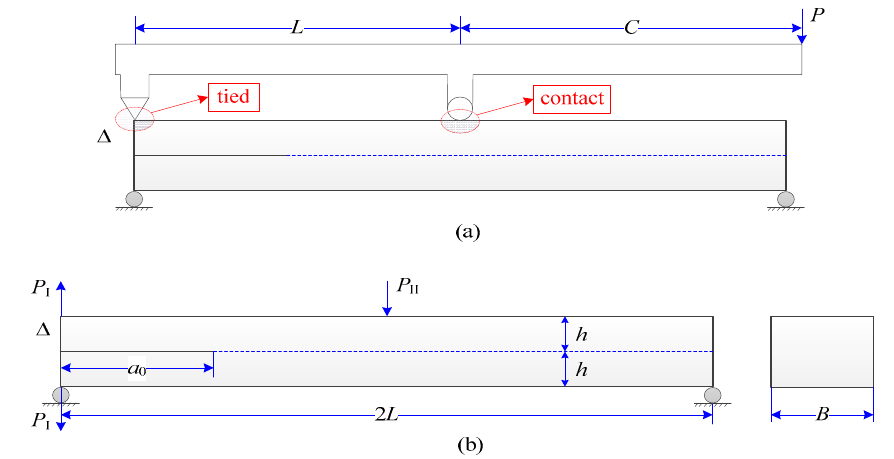
Figure 21. Configuration, loading, and boundary condition of a mixed ‐ mode bending (MMB) model: ( a ) experimental set ‐ up; ( b ) numerical set ‐ up. The mixed ‐ mode ratio β (cid:3404) 𝒢 (cid:2893)(cid:2893) /𝒢 (cid:2904) , where 𝒢 (cid:2904) (cid:3404) 𝒢 (cid:2893) (cid:3397) 𝒢 (cid:2893)(cid:2893) and 𝒢 (cid:2893) and 𝒢 (cid:2893)(cid:2893) are energy release rates